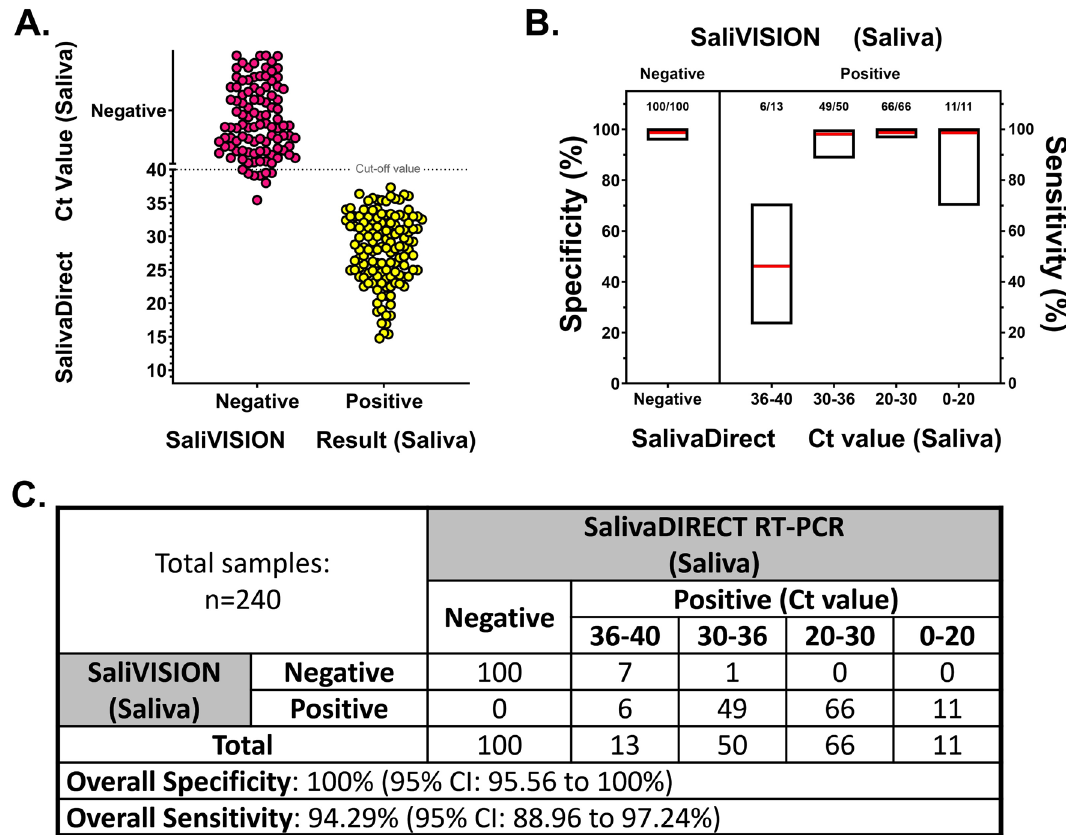
Figure 3. Clinical Validation of SaliVISION, Tested Side-by-Side with SalivaDirect, Using Saliva Samples. Saliva samples being collected for clinical diagnostic test by the Yale Pathology Labs were subjected to SARS-CoV-2 detection using SaliVISION (RT-LAMP) and SalivaDirect (RT-qPCR) methods. In both methods, saliva samples were treated with the lysis buffer and heat-inactivated before being processed. The results of RT-LAMP are compared to relative Ct value determined by quantitative RT-PCR SalivaDirect test. ( A ) The figure represents the distribution of negative (pink) and positive (yellow) samples detected by the SaliVISION test according to their corresponding Ct value detected by the SalivaDirect test (Y axis). The dotted line indicates the cut-off value for SalivaDirect test, in which the samples with Ct value > 40 is considered negative and that with Ct value ≤ 40 is considered positive. ( B ) Specificity (left) and sensitivity (right) of the SaliVISION RT-LAMP assay, derived from data in 3A and C, are shown. For sensitivity, the RT-qPCR positive samples were stratified into four groups, based on the Ct value (x axis). The red lines indicate the value of these proportions. The floating boxes indicate the corresponding 95% confidence intervals computed by Wald’s method. ( C ) The table provides a summary of correlative comparison between the results of SaliVISION and SalivaDirect on the same sample